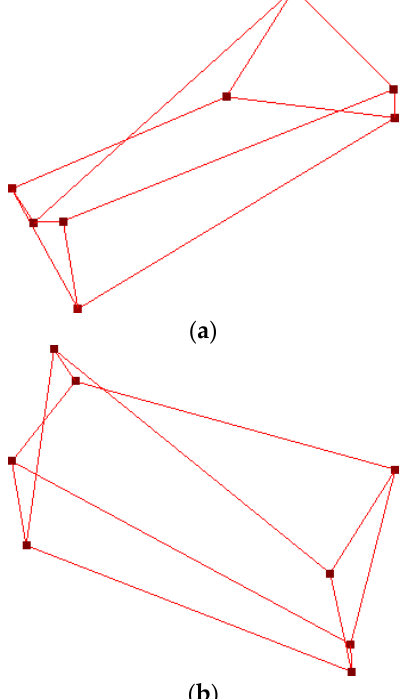
Figure 10. Identified MS at frequency 98.91 Hz: ( a ) first extreme position; ( b ) second extreme position.